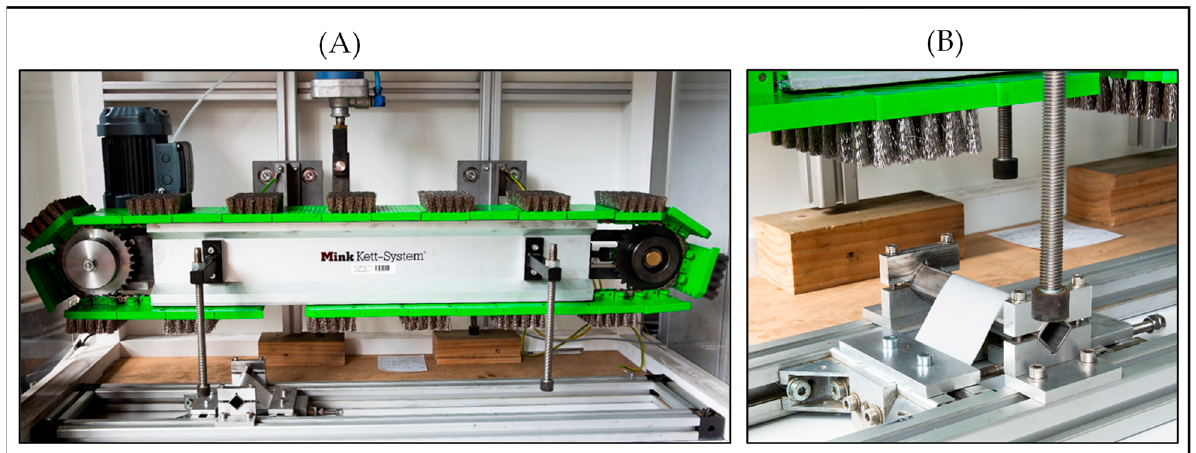
Figure 2. ( A ) Abrasion apparatus. ( B ) Clamped filter media sample.